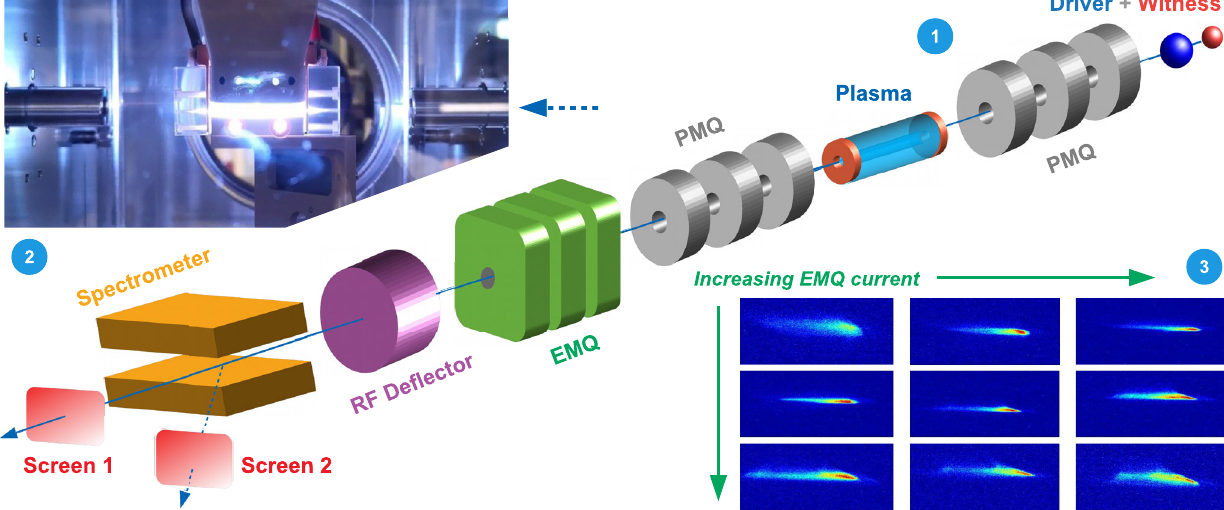
FIG. 1. Experimental setup. (1) The incoming driver and witness bunches are focused by a triplet of permanent-magnet quadrupoles (PMQs) into the plasma accelerator module. A second triplet of PMQs is used to extract and transport the bunches up to two diagnostics stations located on the straight (straight screen, screen 1) and bent (spectrometer screen, screen 2) beam lines. A triplet of electromagnetic quadrupoles (EMQs), a rf-deflector device and a magnetic spectrometer allow to completely characterize the beam. (2) The plasma module consists of a 3 cm-long capillary where the plasma is produced by ionizing H 2 gas with a high-voltage discharge. (3) The inset shows a typical quadrupole scan of the plasma accelerated witness performed on the spectrometer screen by varying the EMQ currents to reconstruct its normalized